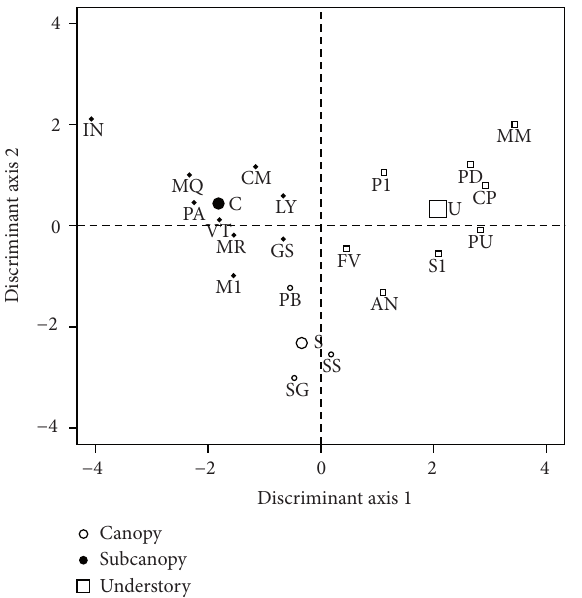
F 9: Discriminant space obtained by LDA using absorbance variables. Shown are centroid (large symbols) and species locations (small symbols) for the three